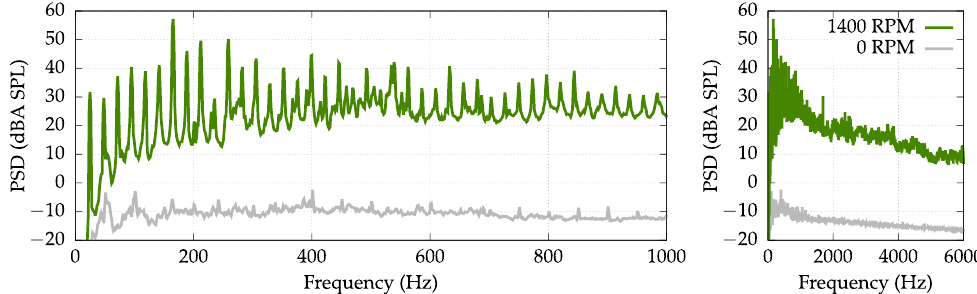
Figure 4. PSD with an A-weighting measured at M0–M3 locations using four measurement micro- phones. Unbalanced load of 400 g. Spin velocity equal to 1400